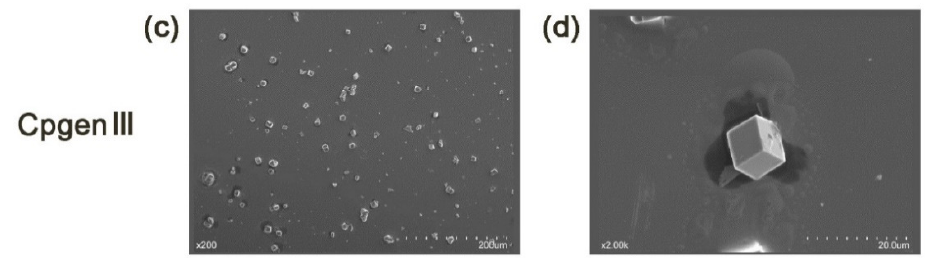
Figure 4. Scanning electron microscopic view of calcite crystals grown in the absence or presence ( a , b , control) of Cpgen Ⅲ ( c , d ). The scale bars are indicated at the bottom right of the pictures, and the magnification is shown at the bottom left.